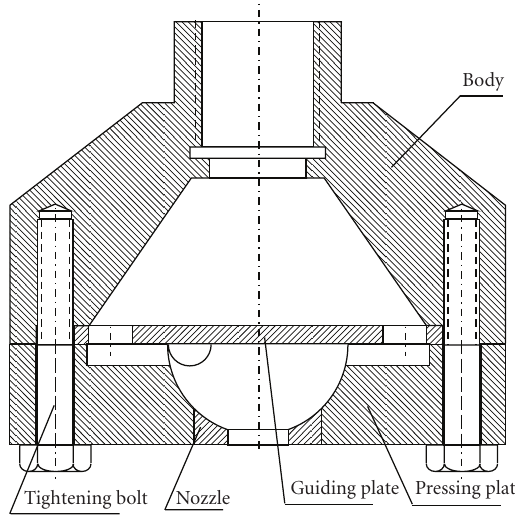
Figure 6: The large flowrate eddy pressure nozzle